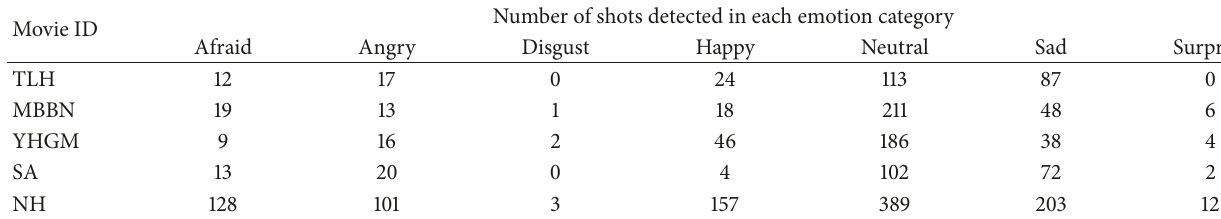
Table 4: Statistics of all the detected emotions in the informative shots of the test movies.